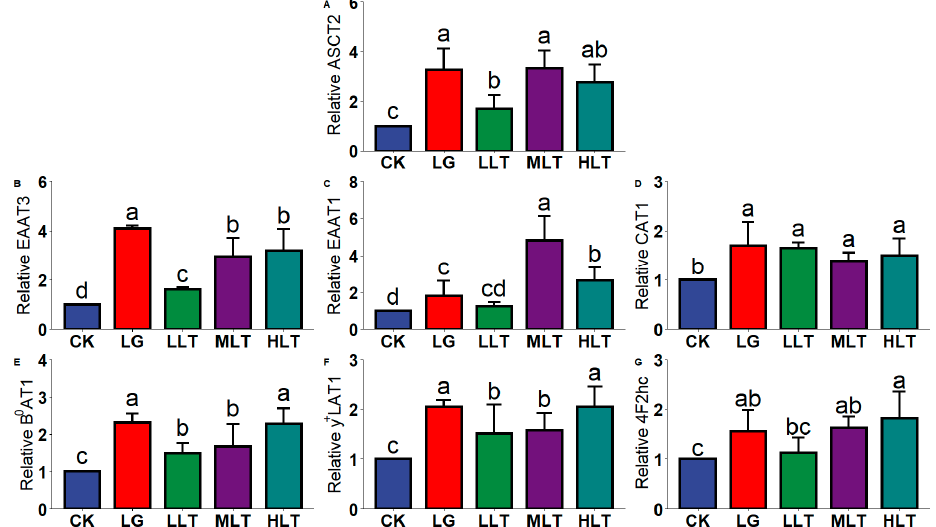
Figure 2. Effects of L-theanine on mRNA expression of amino acid transporters of ( A ) ASCT2, ( B ) EAAT3, ( C ) EAAT1, ( D ) CAT1, ( E ) B 0 AT1, ( F ) y + LAT1, and ( G ) 4F2hc in the jejunum of mice. CK (control), HLT (LTA—400 mg•kg − 1 •d − 1 ), MLT (LTA—300 mg•kg − 1 •d − 1 ), LLT (LTA—100 mg•kg − 1 •d − 1 ), and LG (L-glutamine—300 mg•kg − 1 •d − 1 ) groups. Values are presented as mean ± SD; n = 10/group. Different superscript letters in the same figure indicate statistically significant differences ( p < 0.05).